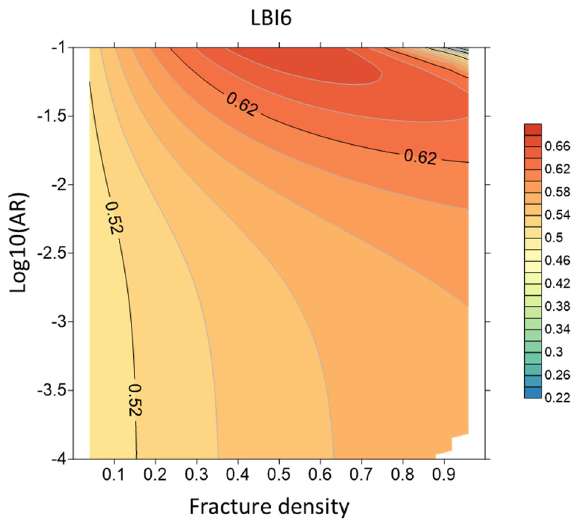
Figure 10. Brittleness index LBI 6 versus fracture density and decimal logarithm of aspect